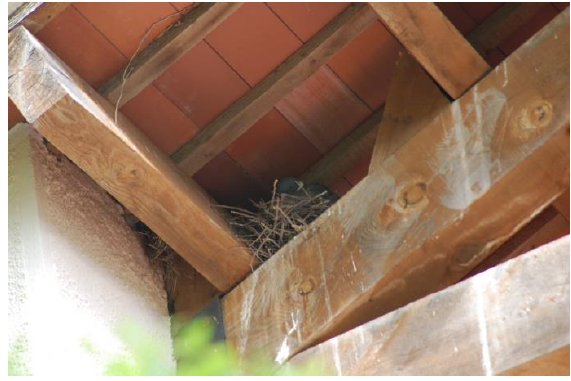
Figure 1. A wood pigeon ( Columba palumbus ) pair nesting on a human construction built its nest with sticks as an evolutionary load of what they do when nesting on trees, their original nesting habitat. Nests on human constructions are typical of rock pigeons ( C. livia ) that are cliff-nesting species and do not supply nests with sticks. Human constructions are functionally equivalent to cliffs and are typically used by cliff-nesting bird species (Photo credit: Andreu